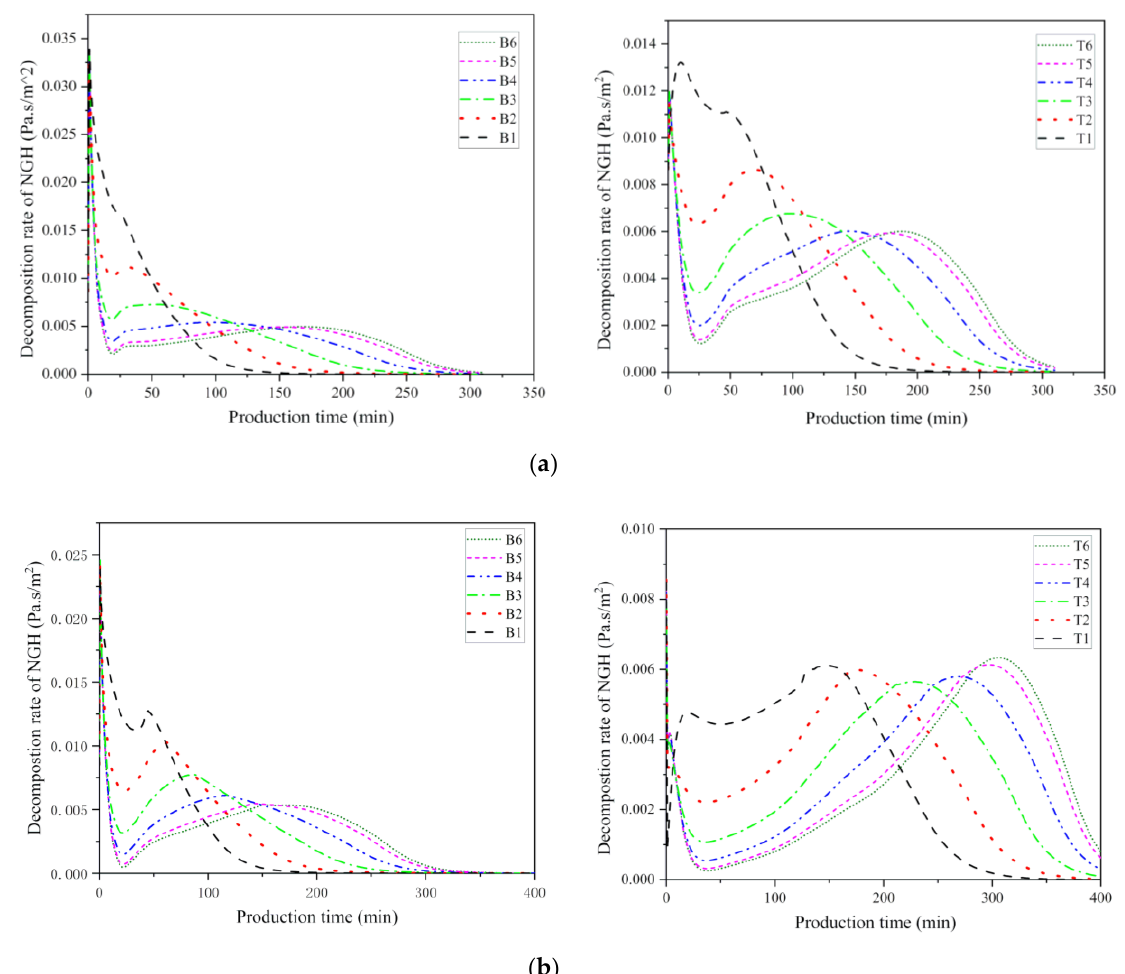
Figure 8. NGH decomposition rare variation with production time for the mechanical ( a ) uncoupled and ( b ) coupled models.